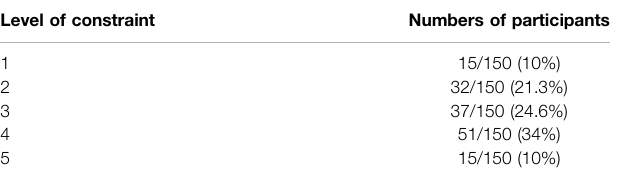
TABLE 8 | Perceived level of constraint on a scale from1 to 5 (5 is very constraining).